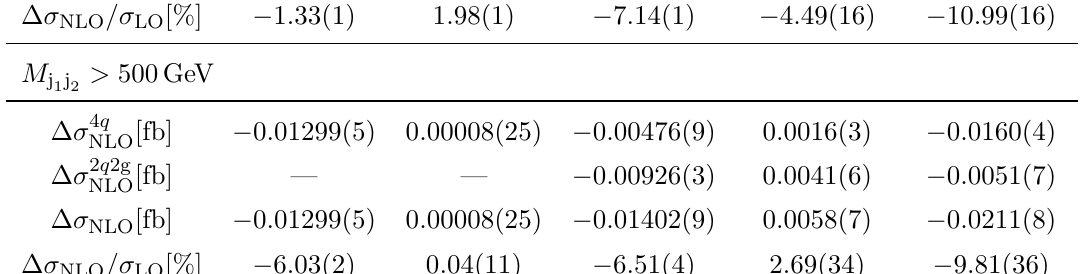
Table 2 . NLO corrections for the process pp → e + e − µ + µ − jj + X at the orders O (cid:0) (cid:1) (cid:0) (cid:1) O α 2 α 5 , O α 3 α 4 , and for the sum of the four NLO corrections. Contributions of partonic channels s s involving four quarks, σ 4 q , and those involving two quarks, σ 2 q 2 g LO bution ∆ σ NLO corresponds to the absolute correction for the central scale choice, while ∆ σ NLO /σ LO gives the relative correction normalised to the sum of all LO contributions at the central scale. The absolute contributions are expressed in femtobarn while the relative ones are expressed in per